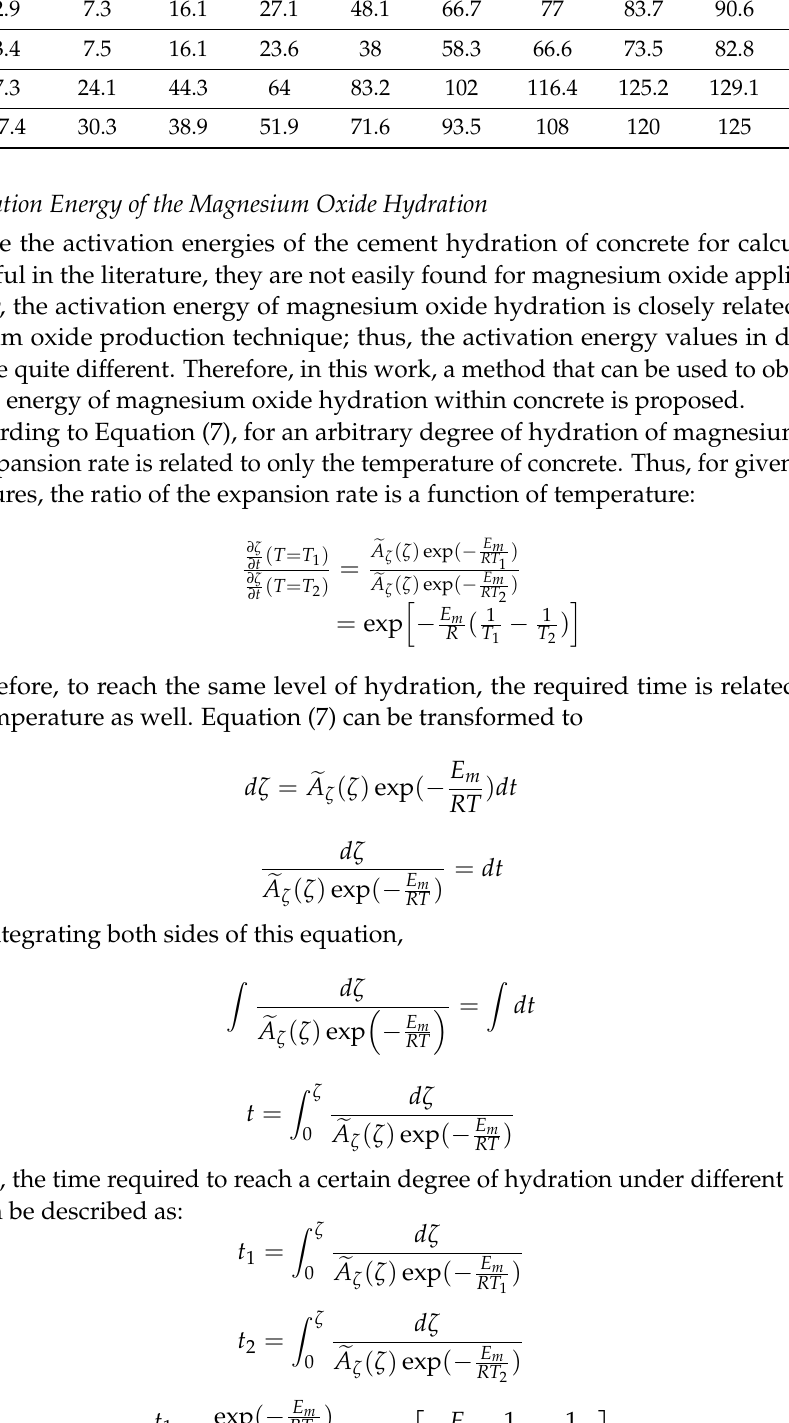
Table 3. Autogenous volume deformation of oxygen magnesia concrete samples at different ages with varying water–binder ratios and curing temperatures. Fly Ash